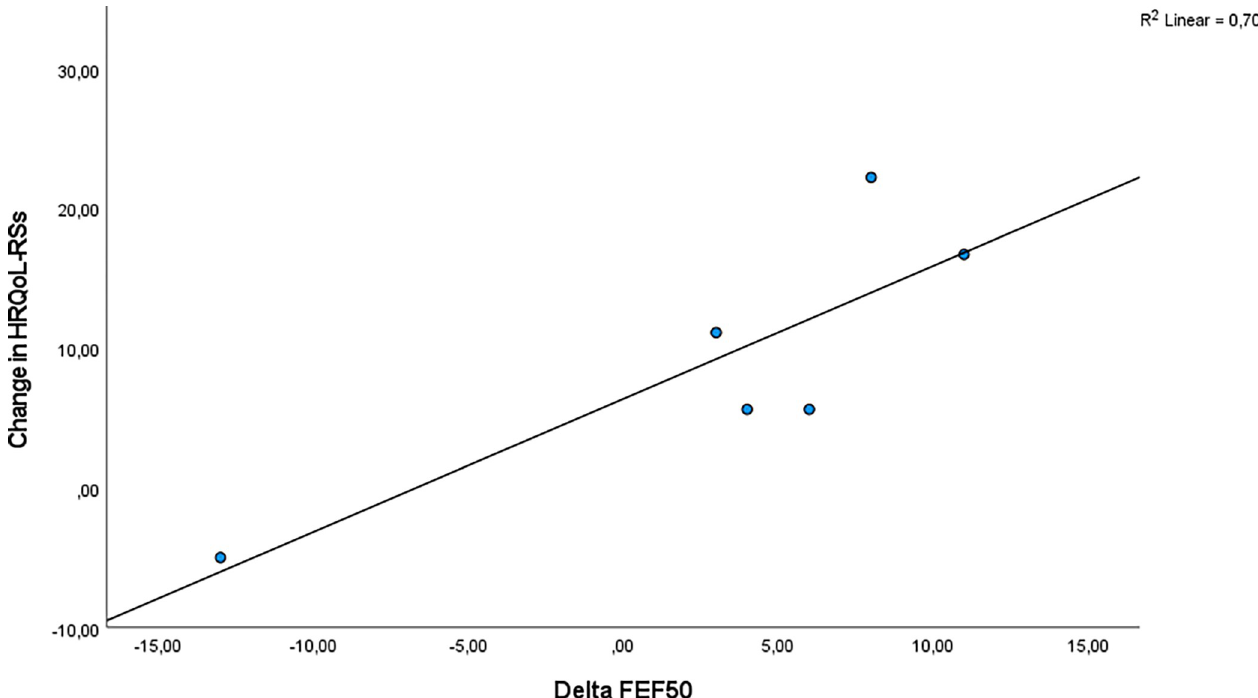
Fig 4. The correlation between change in FEF50 (start and end of study) and the change in CFQ-R-RSS (start and end of study).